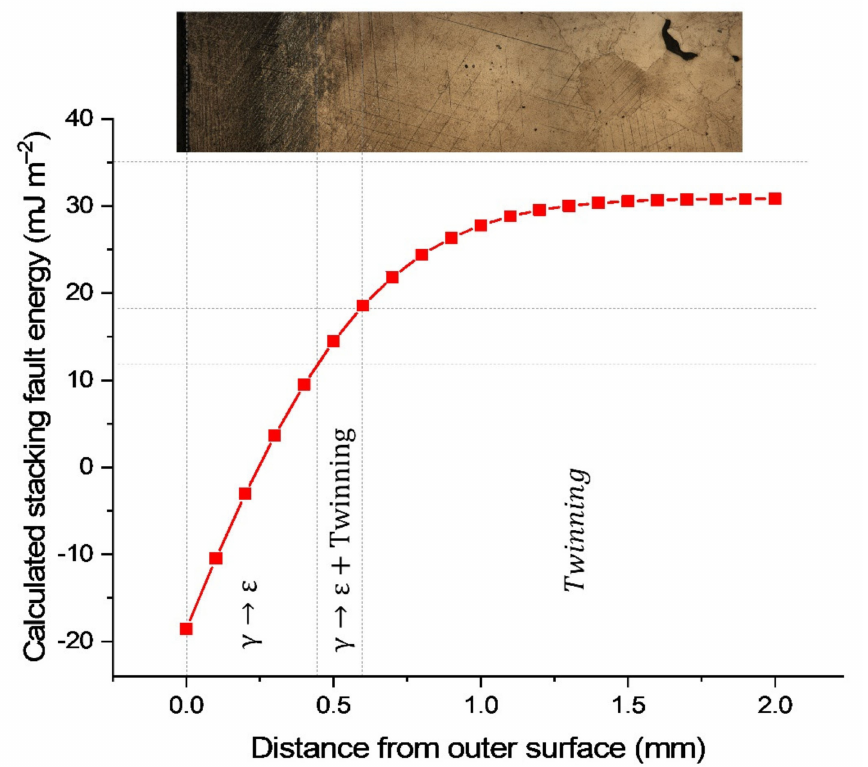
Figure 6. SFE profile, relationship between SFE-Deformation mechanism and microstructure of the decarburized Hadfield